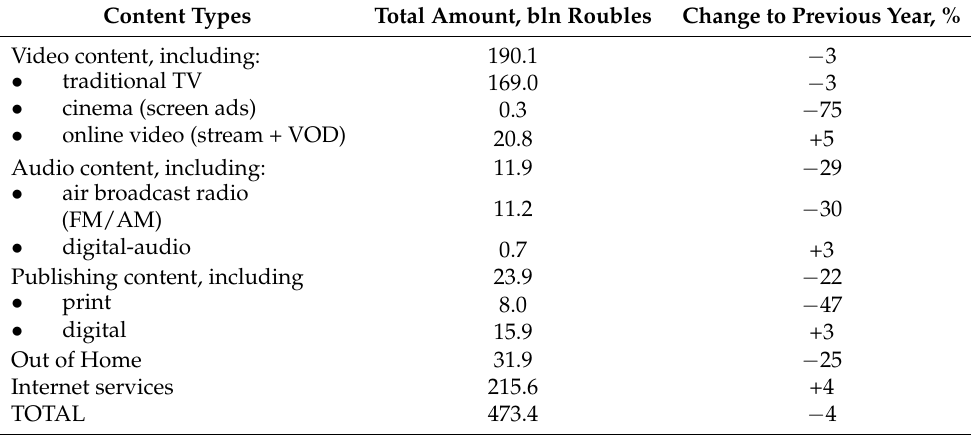
Table 1. Content specific advertising in